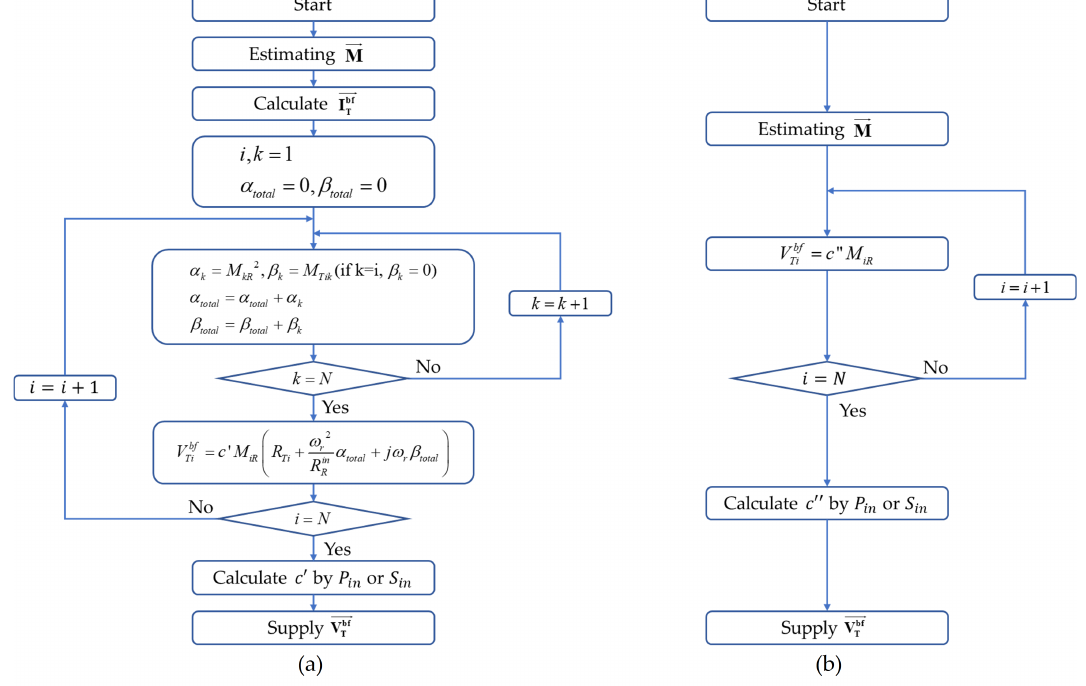
Figure 19. Algorithm for